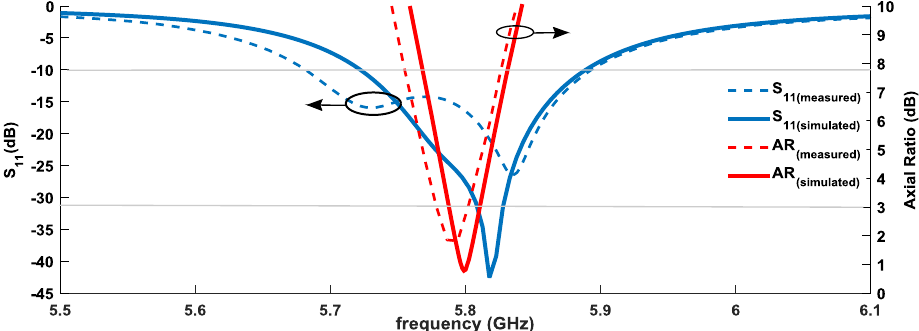
Figure 3. Simulated and measured S 11 and axial ratio (AR) of the designed circular patch antenna.